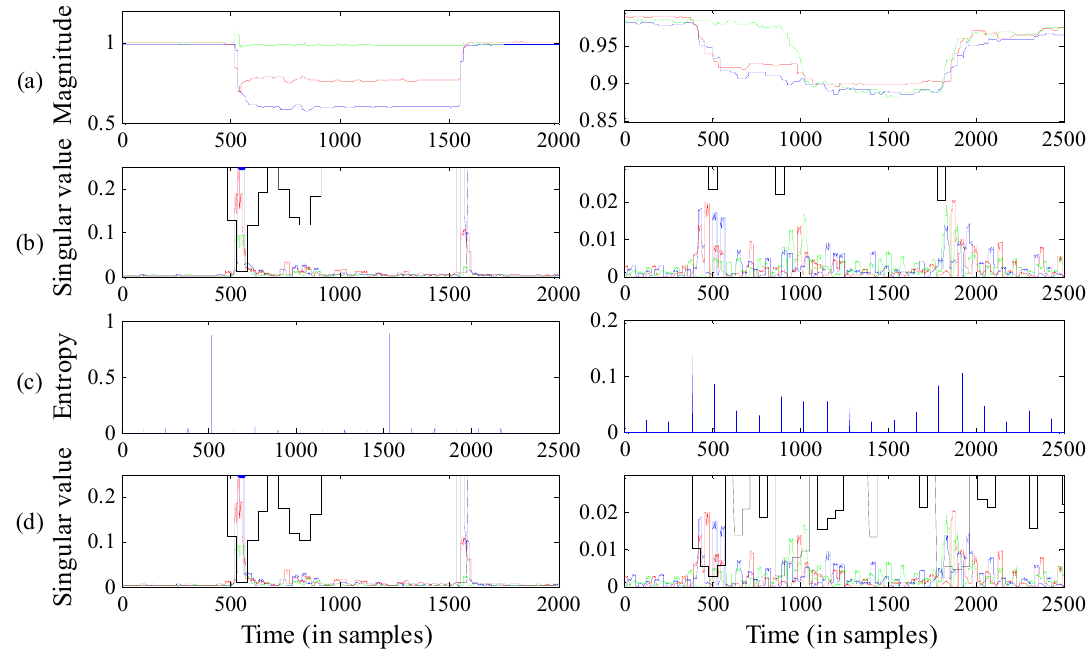
Figure 13. The segmentation results with different thresholds: ( a ) voltage magnitude; ( b ) Th2; ( c ) entropy; (d) Th3.